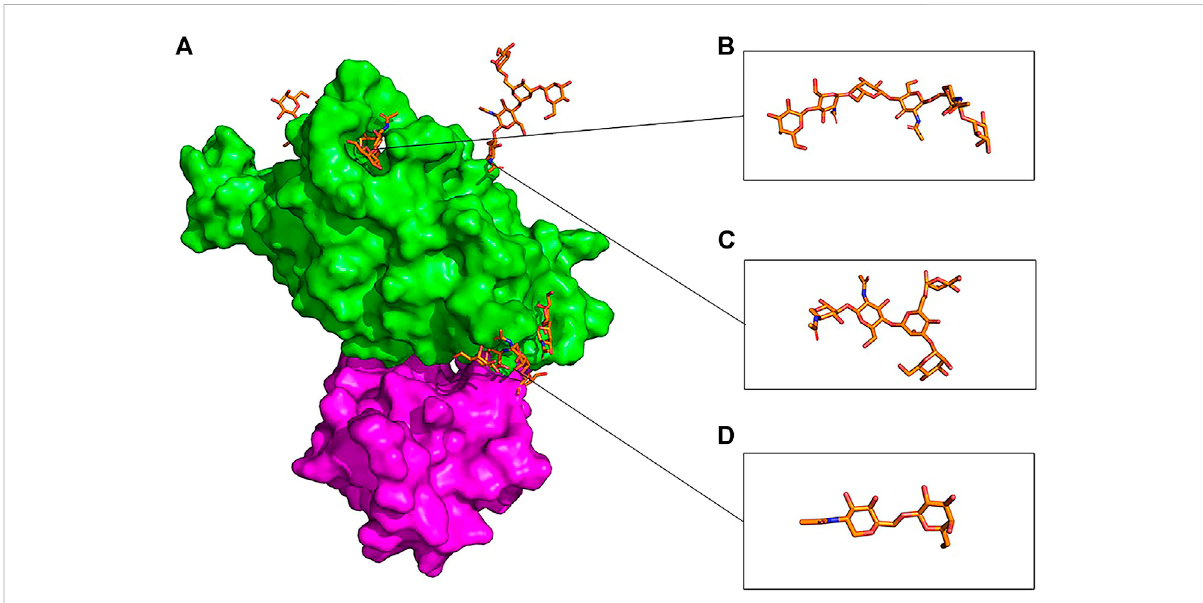
FIGURE 10 Overlaid presentation of glycosylated RBD inthegmRBDfNsystem isshown on the green surface, and ferritin isshown on thepurple surfacein picture (A) . S494 O-glycan is shown in picture (B) , N343 N-glycan is shown in picture (C) , and O-glycan core is shown in picture (D) with orange sticks.